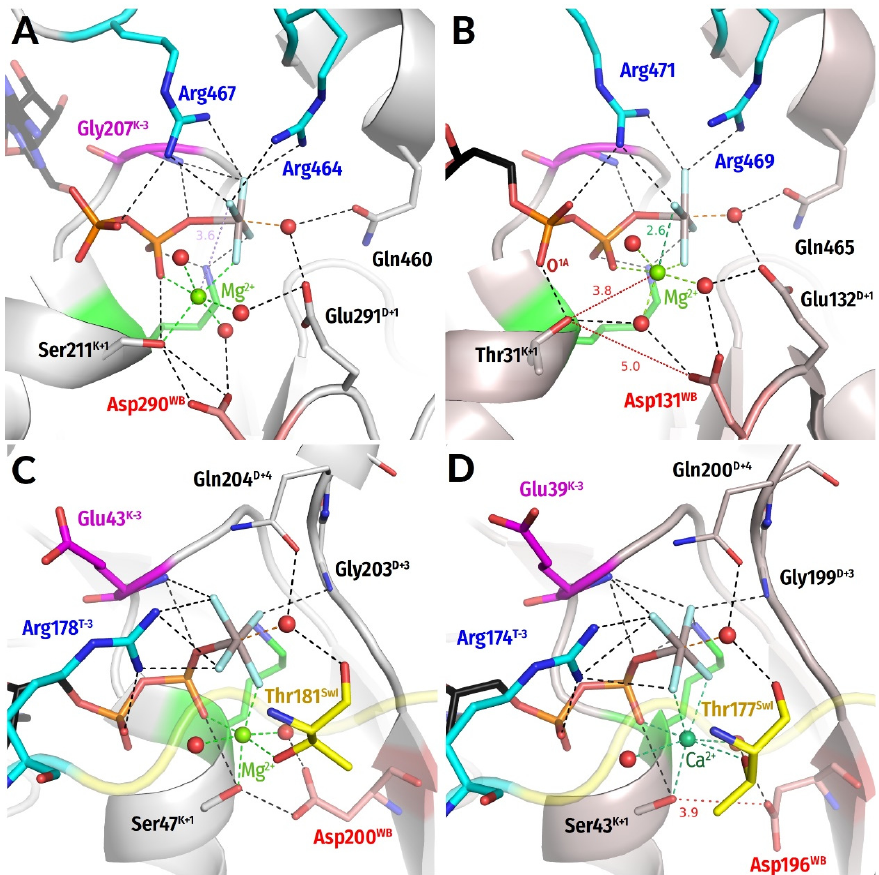
Figure 6. Variation in the AlF 4 − interaction with Mg 2+ ions. The Switch I motif is colored yellow, and the Ca 2+ ion is shown as a teal sphere. Otherwise, the colour code is as in Figure 1C,D. The distances that are too long for H-bonds are indicated by red dotted lines. All distances are given in ångströms. ( A ) ADP:AlF 4 − binding in the structure of HCV (hepatitis C virus) NS3 helicase, PDB 5E4F, chain A [96]. The Mg 2+ ion is coordinated by the O 2B atom of ADP, one fluorine atom of AlF 4 − , the conserved Ser residue of the Walker A motif, and three water molecules. ( B ) The ADP:AlF 4 − binding in the structure of double-stranded RNA (dsRNA)-dependent helicase LGP2 from chicken (PDB 5JAJ [97]). Here, AlF 4 − is rotated counterclockwise and makes two bonds with the Mg 2+ ion; the Ser K+1 residue is no longer directly coordinating Mg 2+ , and instead is forming an unusual bond with the O 1A atom of ADP. ( C ) The AlF 4 − binding in the structure of guanine nucleotide-binding protein G α i3 complexed with the regulator of G-protein signaling 8 (PDB 2ODE [98]). The Mg 2+ ion is coordinated by the O 2B atom of GDP, one fluorine atom of AlF 4 − , the conserved Ser residue of Walker A motif, the conserved Thr of Switch I, and two water molecules. ( D ) In the structure of transducin Gt α complexed with Ca 2+ instead of Mg 2+ (PDB 1TAD [31]), AlF 4 − is rotated and forms two bonds with Ca 2+ , but all interactions in the coordination sphere are preserved due to a larger ionic radius of Ca 2+ and its ability to bind up to 8 ligands. However, the catalytic site is more open, as evidenced by a distance of 3.9 Å between Ser K+1 and Asp WB